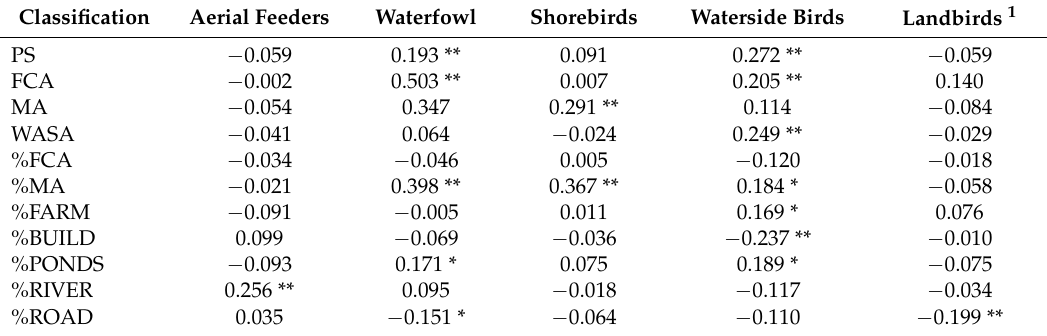
Table 5. Pearson product–moment correlation coefficients indicating the correlation between guild species individuals and pondscape